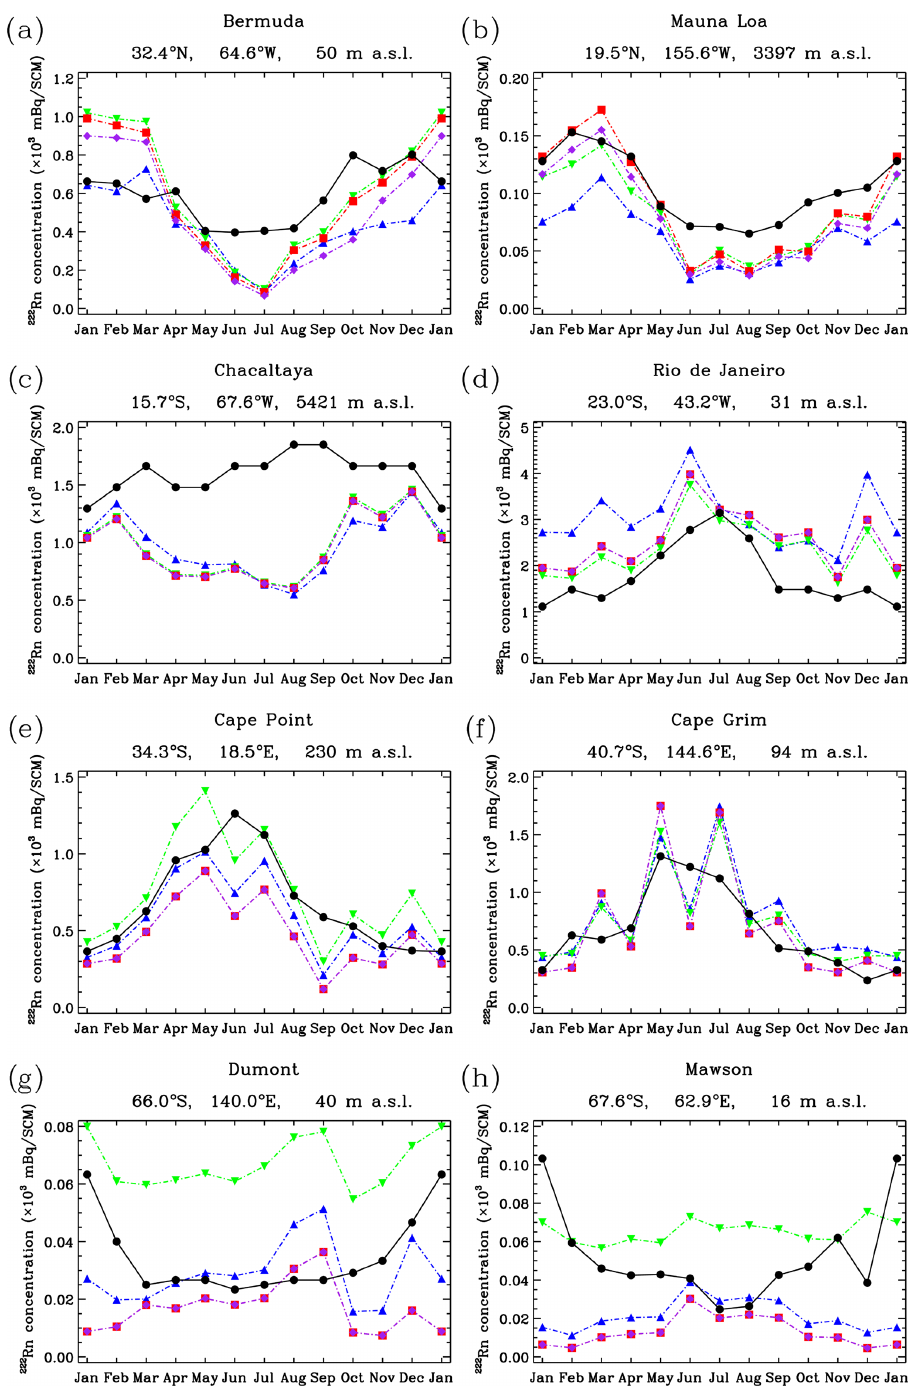
Figure 11. Same as Fig. 8 but for remote sites.